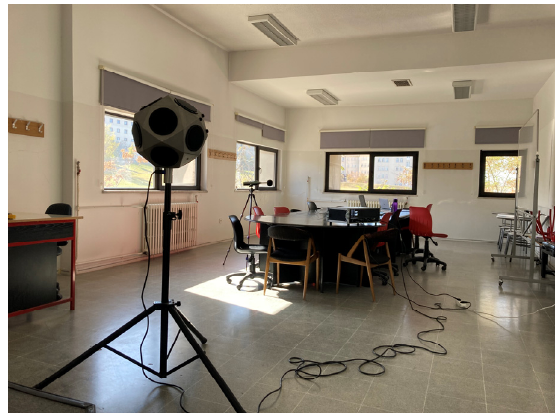
Figure 6. In situ measurements of the classroom.